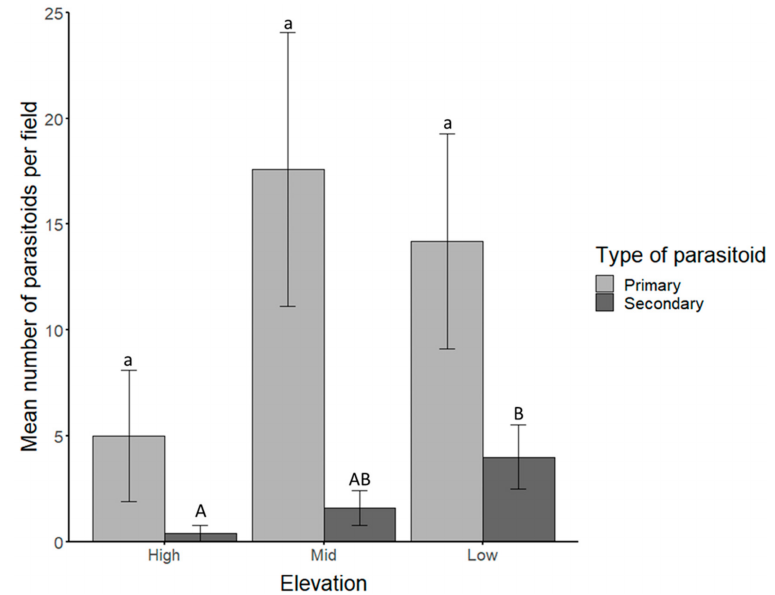
Figure 1. Mean numbers of primary (light gray) and secondary (dark gray) parasitoids emerged from Aphis fabae (Hemiptera: Aphididae) on sentinel plants in each field at high-, mid- and low-elevations. Significant di ff erences ( p < 0.05) are indicated by di ff erent lowercase (primary parasitoids: a) and uppercase (secondary parasitoids: A , B , AB )